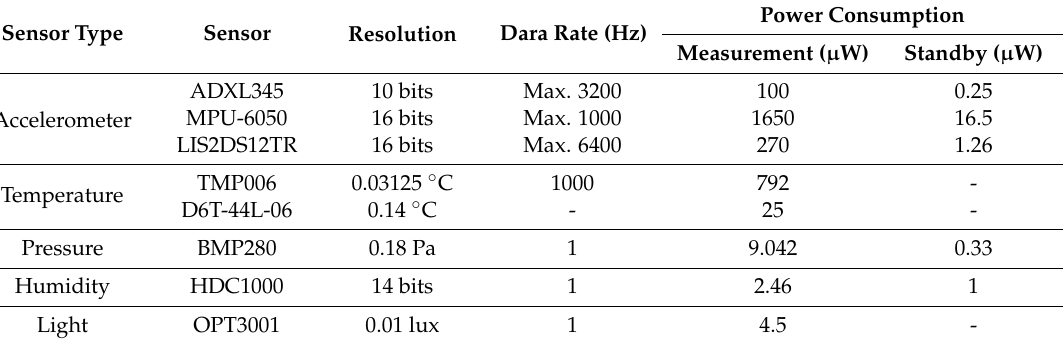
Table 4. Typical sensor modules and